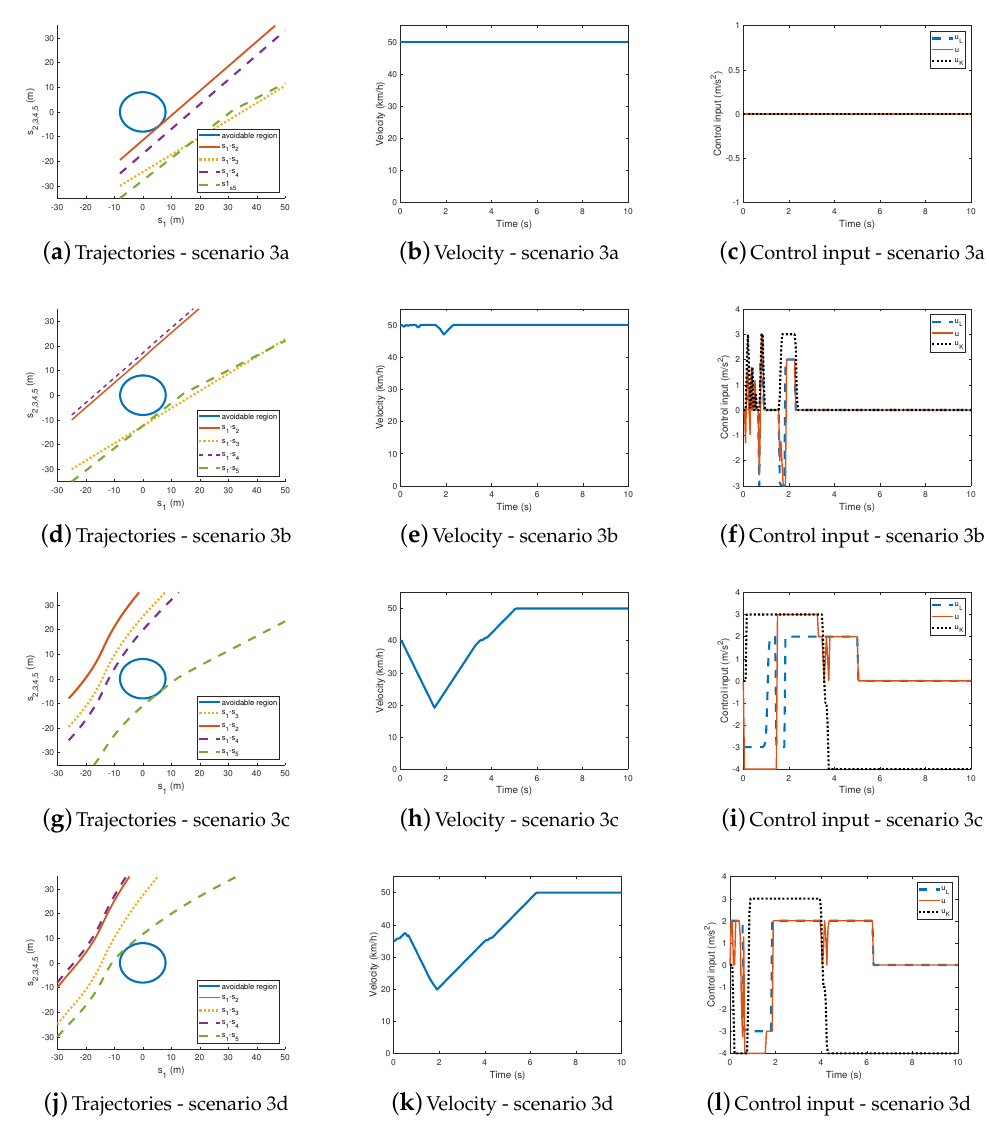
Figure 8. Signals of third